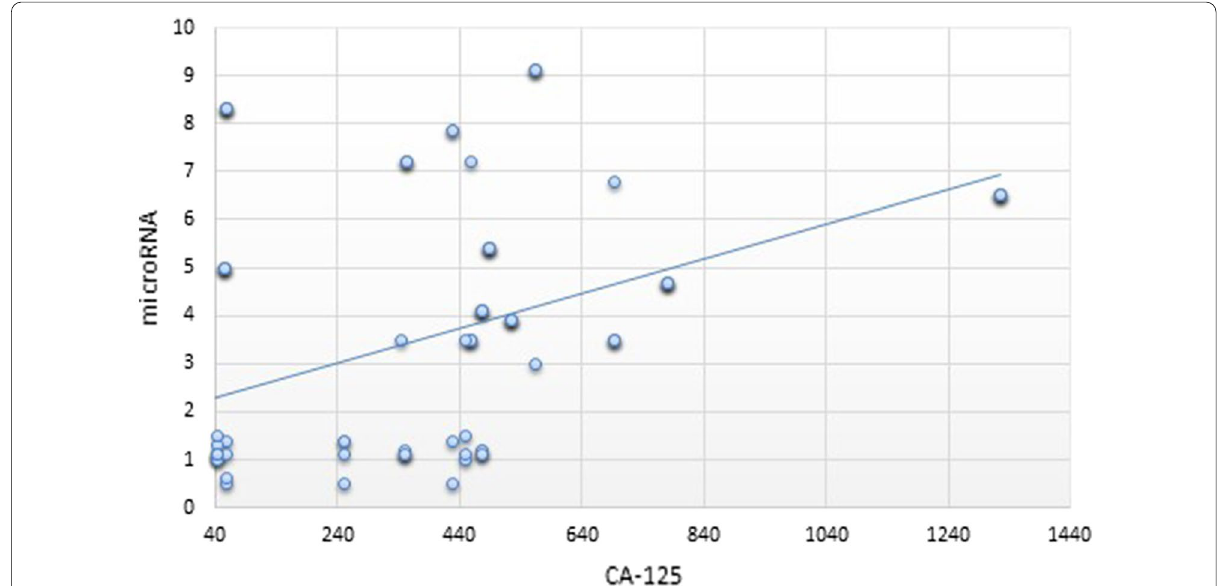
Fig. 2 Correlation between CA-125 and miRN-21 among the studied